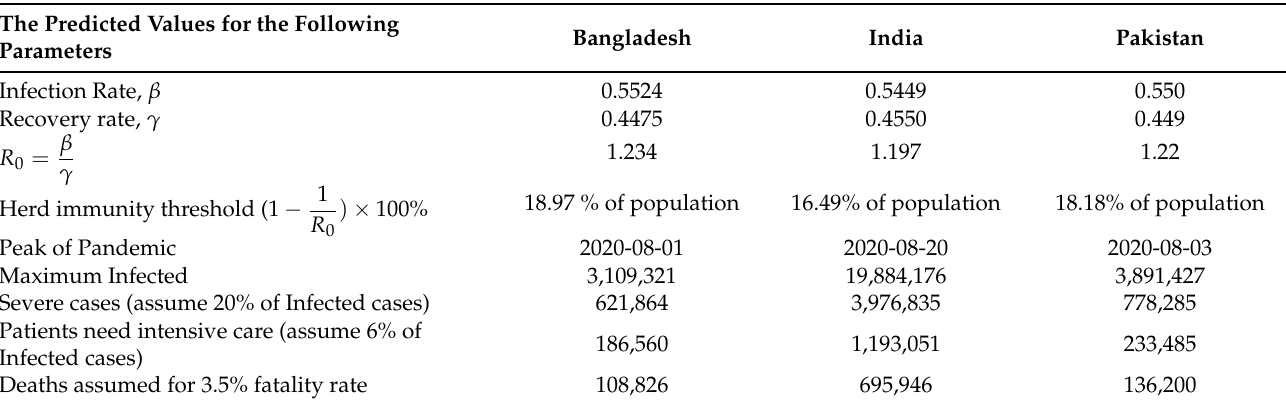
Table 2. Prediction with SIR